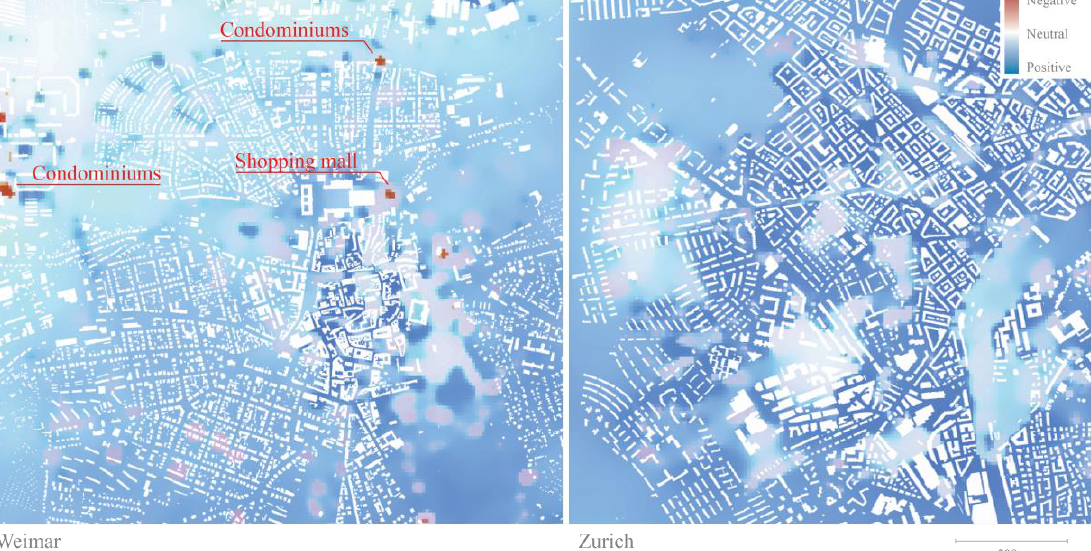
Figure 10. Extrapolated (from path to district) predictions of the psychological potential based on the decision tree predictive model for Weimar ( left ) and Zurich ( right ). The prediction combines the subjective ratings and the physiological arousal to estimate the size and the direction of the psychological potential of urban form (from negative-dark red to positive-dark blue).